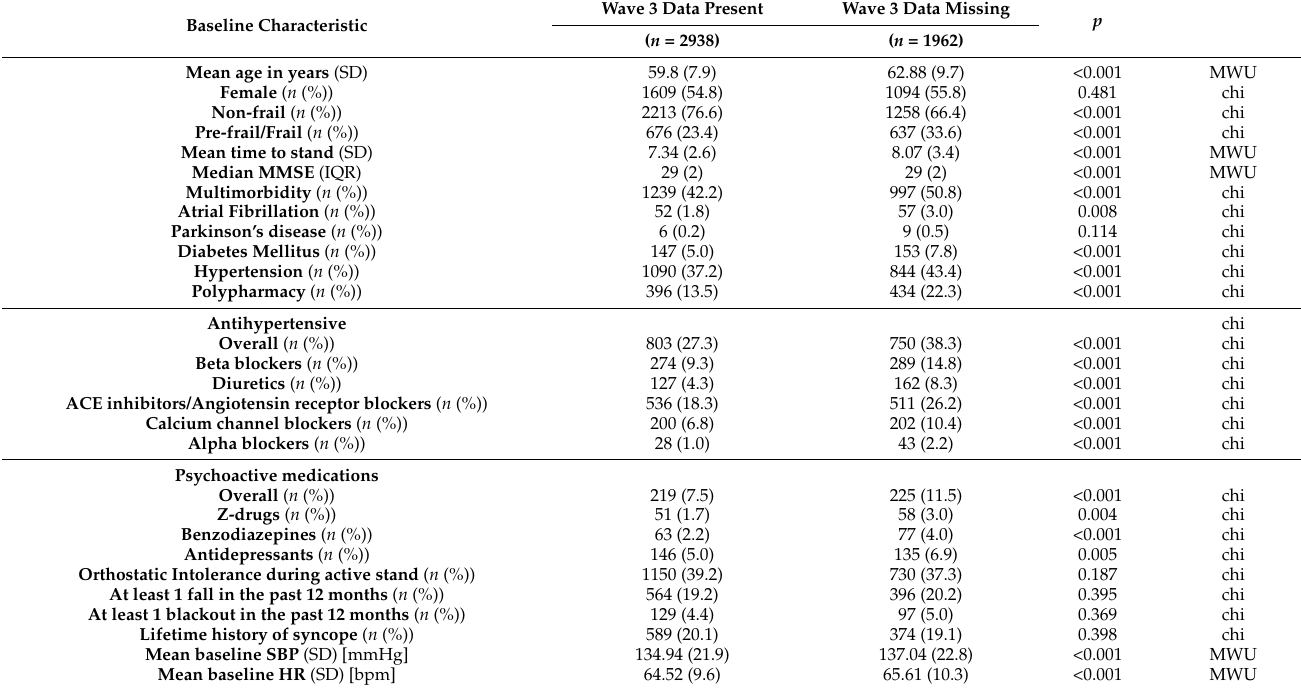
Table 3. Comparison of Wave 1 baseline characteristics of both the overall sample and attrition sample. Baseline